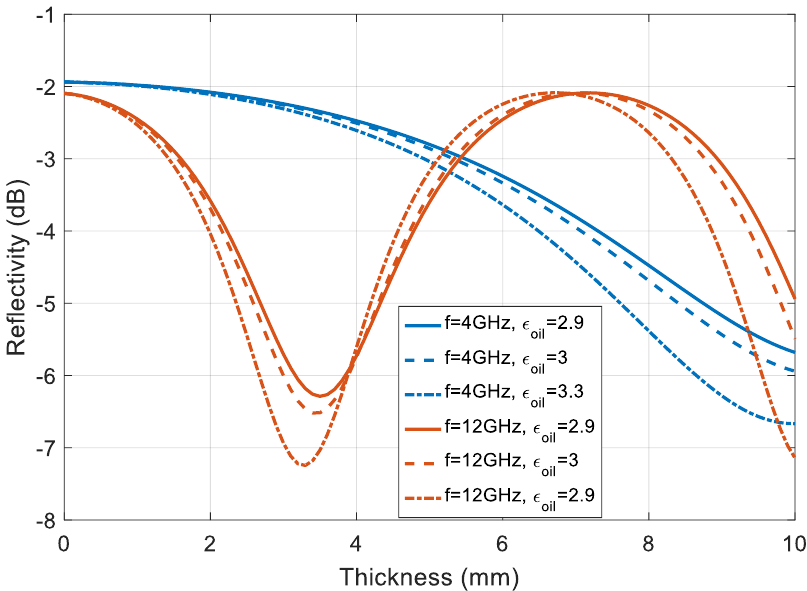
Figure 3. Reflectivity R (in dB) versus oil thickness (in mm) at different frequencies (4 GHz, and 12 GHz) and different oil dielectric constants. The electromagnetic roughness is ks = 0.5.